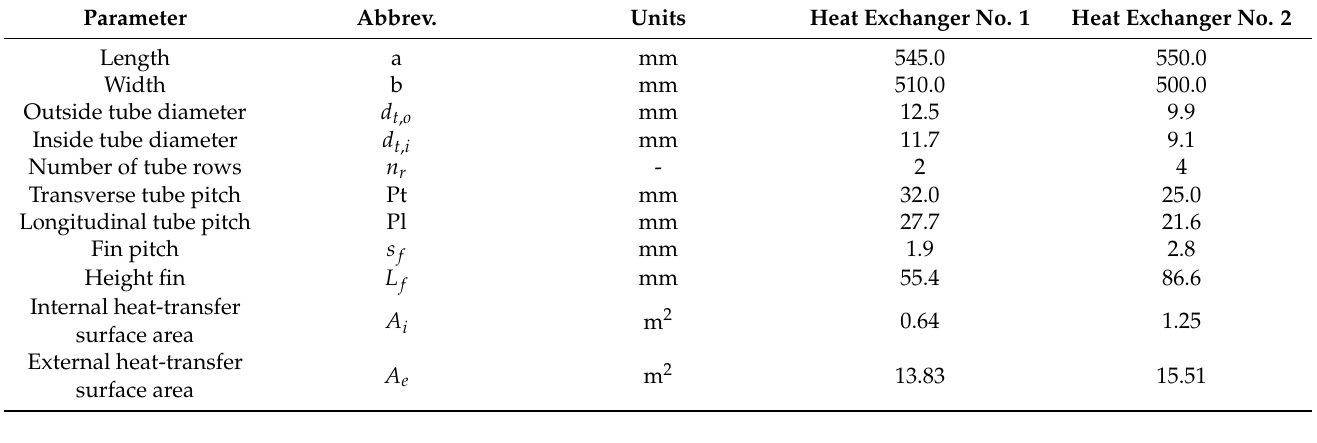
Table 1. The geometric parameters of the heat exchangers tested.